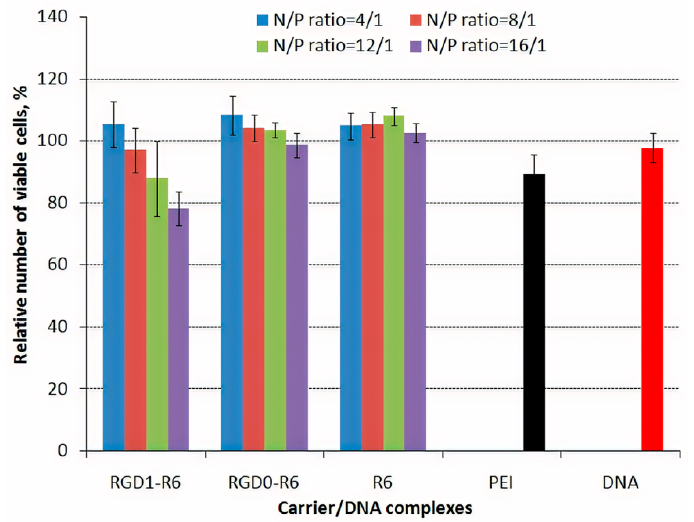
Figure 6. The cytotoxicity after transfection of DNA complexes with RGD1-R6, RGD0-R6 and R6 carriers. Values are the mean ± SD of the mean of triplicates.